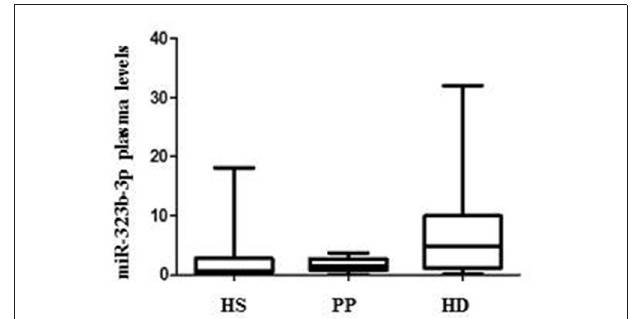
FIGURE 2 | Differential plasma levels of miR-323b-3p in Huntington’s disease (HD), healthy subjects (HS), and psychiatric patients (PP). Values are expressed as copies/ µ l. The horizontal line in the middle of each box indicate the median, whereas the top and bottom black lines the 75th and 25th percentiles, respectively. Mann–Whitney U test. p < 0.05.